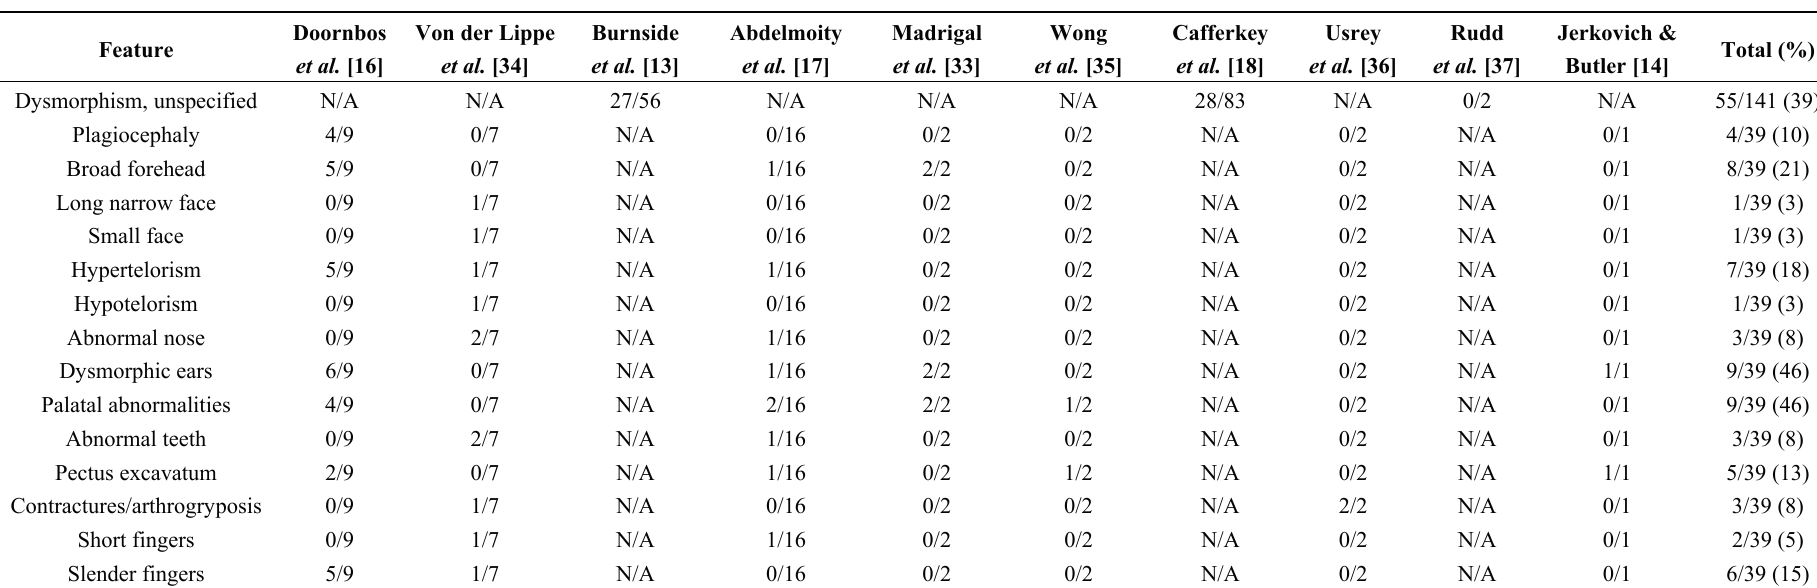
Table 2. Literature Review of Dysmorphic Features for Individuals with Chromosome 15q11.2 BP1–BP2 Microdeletion